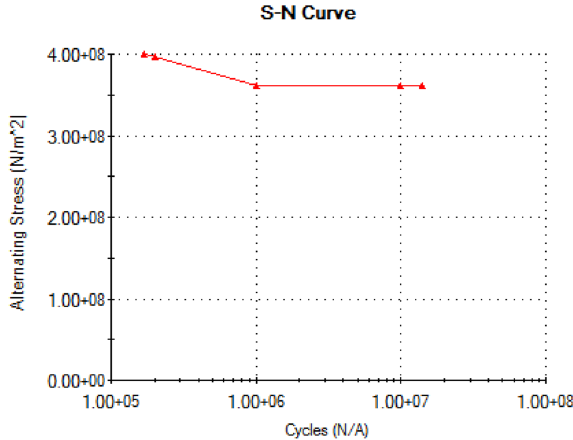
Figure 28. Fatigue stress-life (S–N)